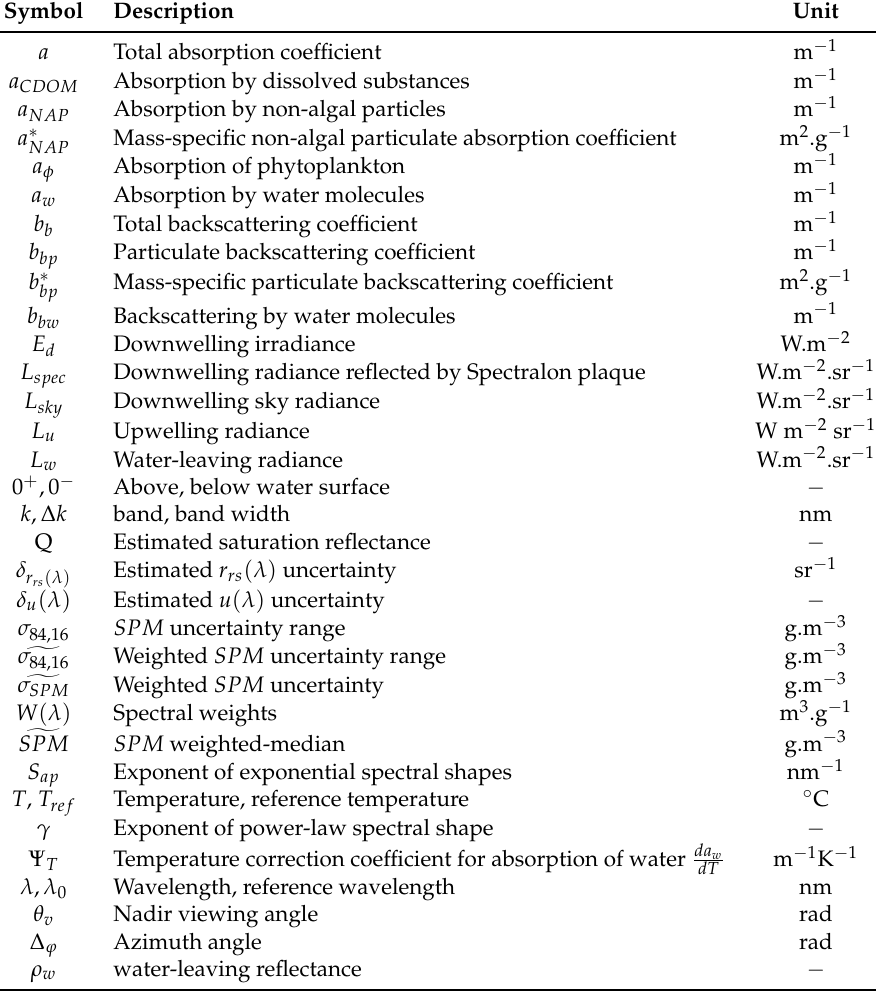
Table 3. Symbols, definitions, and